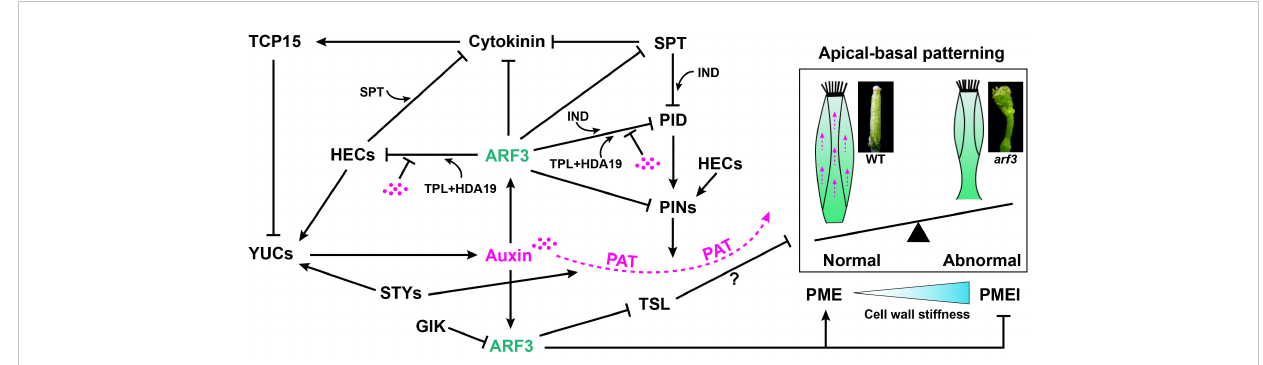
FIGURE 4 A model of the ARF3-mediated regulatory network in the apical/basal axis formation of gynoecia. Solid arrow indicates positive regulation. Block lines indicate negative regulation. Dashed arrow indicates polar auxin transport (PAT). The magenta dots indicate